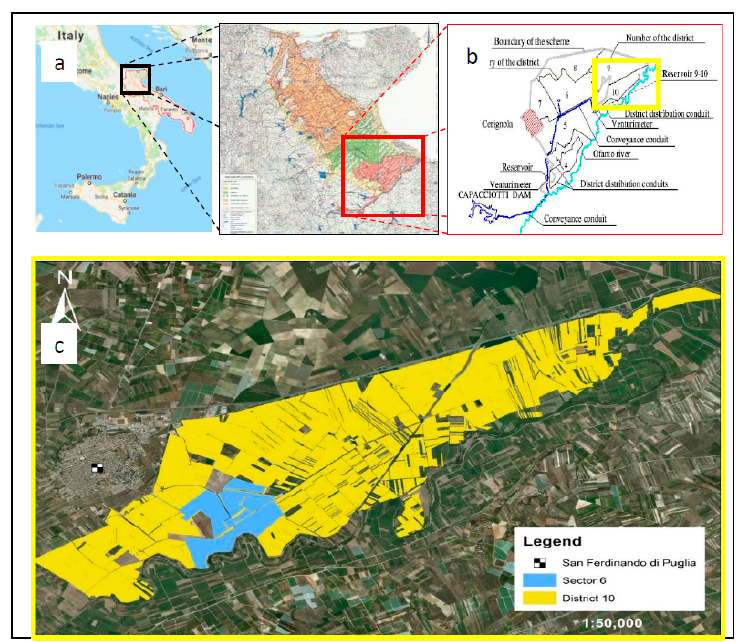
Figure 3. The study area ( a ). The hydraulic scheme of the low-zone ( b ). Sector 6 of district 10 in the “Sinistra Ofanto” irrigation system ( c ).